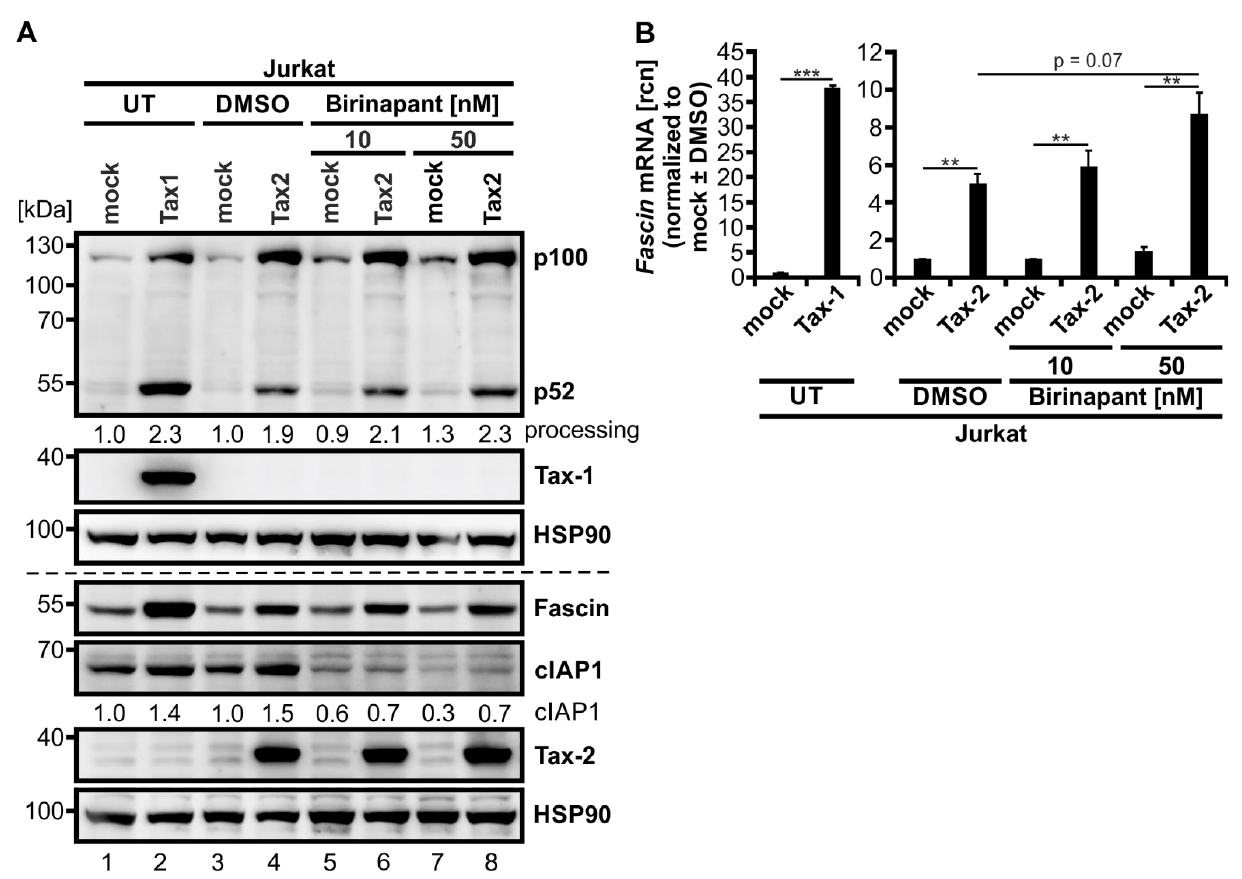
Figure A2. Impact of the SMAC-mimetic Birinapant on cIAP1 degradation, p100 processing and